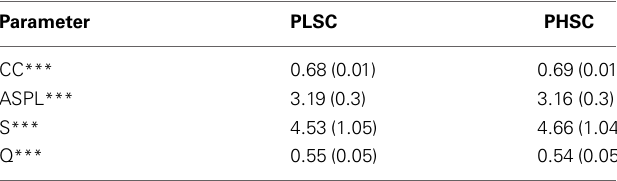
Table 4 | SWN measures calculated for the partial LSC and HSC semantic networks (standard deviations in brackets).